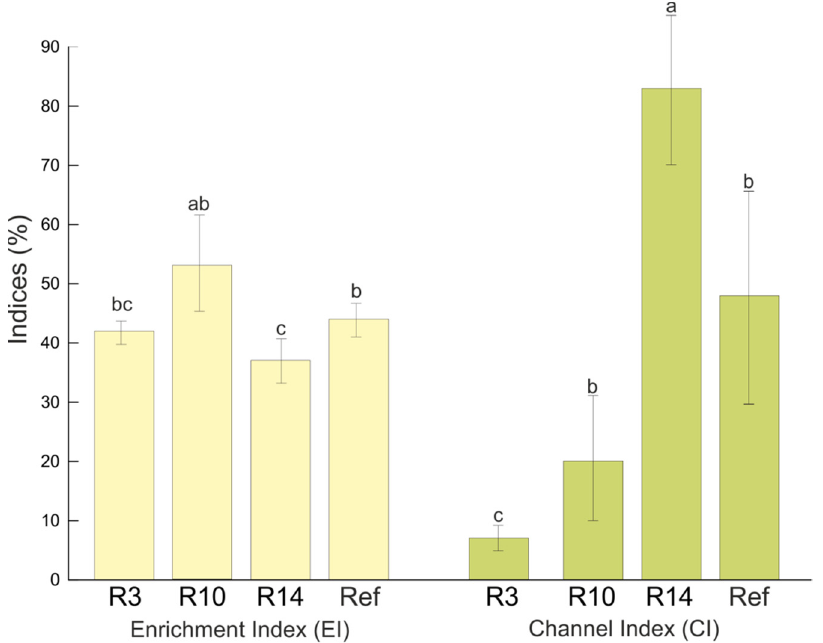
Figure 3. Enrichment Index and Channel Index in the three reclaimed sections (R3, R10 andR14) and references sites (Ref) ( n = 9, mean ± standard. error). Di ff erent letters are used to depict significant references sites (Ref) ( n = 9, mean ± standard. error). Different letters are used to depict significant di ff erences between sites according to an LSD test. differences between sites according to an LSD test.